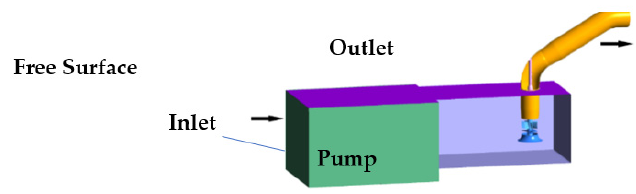
Figure 1. Open sump for water treatment pumping station.